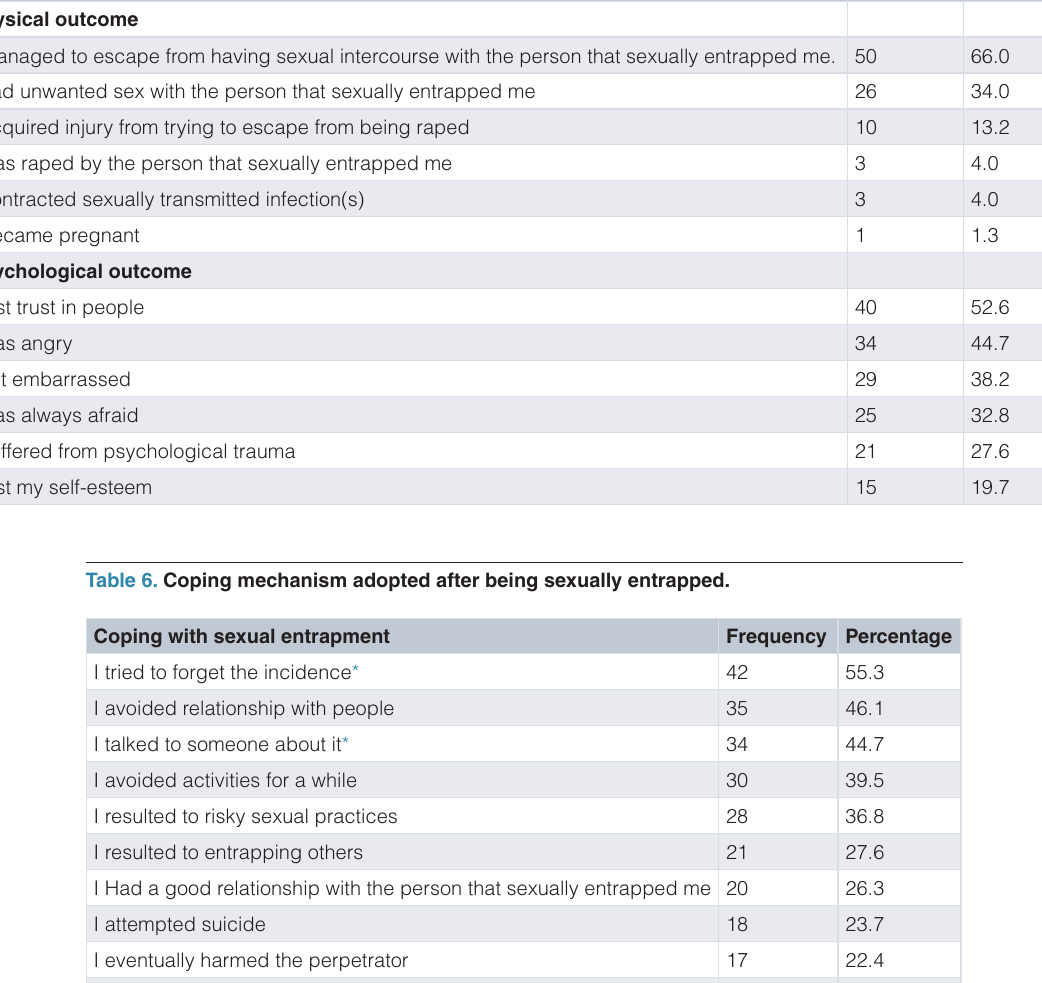
Table 5. Outcome of sexual entrapment. Outcome of sexual